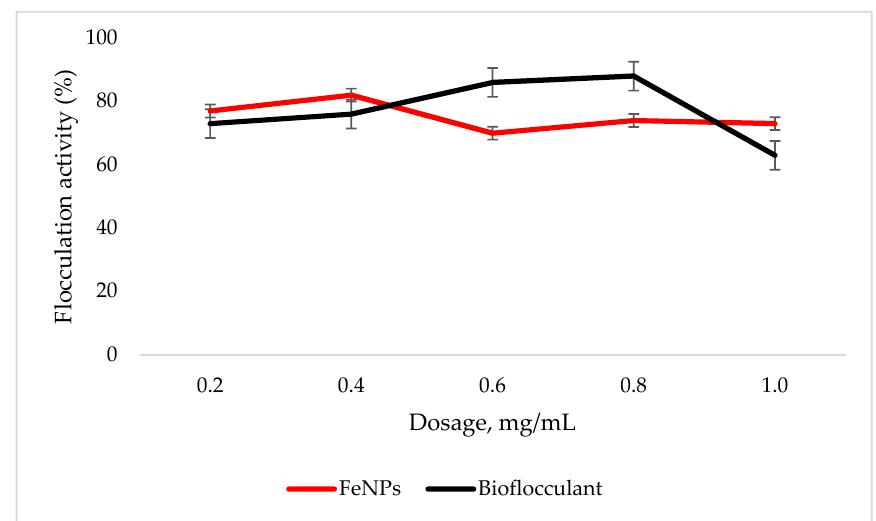
Figure 4. Dosage effect on flocculation activity. Error bars denote statistical significance at (p < 0.05).